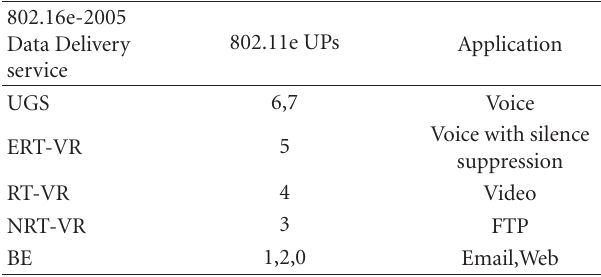
Table 2: QoS mapping between IEEE 802.11e and IEEE 802.16e- 2005